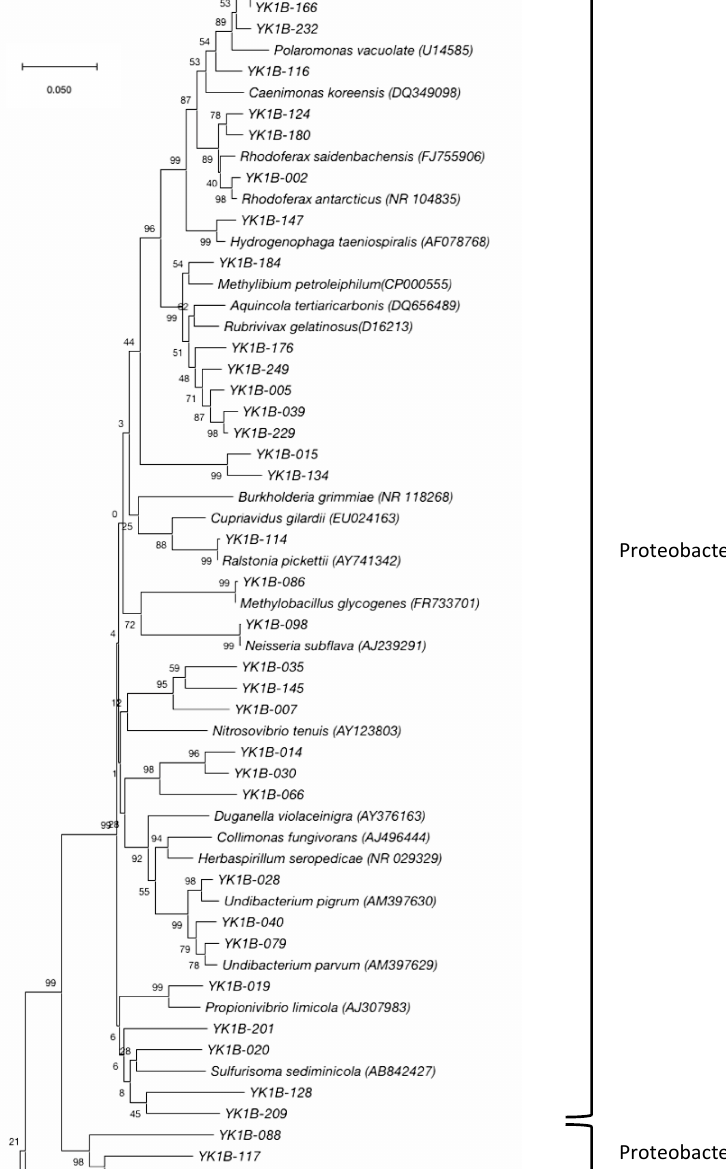
Figure 5. Phylogenetic tree of Beta- and Gamma-proteobacteria clones. The DNA database accession numbers for described species are in parentheses. The bar indicates evolutionally distance. The bootstrap value of each node is indicated.